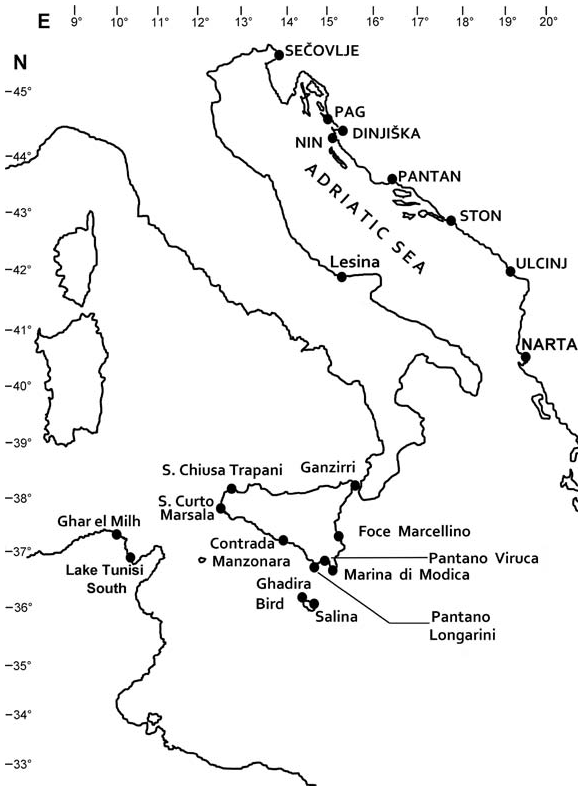
Fig. 1. – Map of the investigated area with marked sampling locali- ties. The locations on the eastern Adriatic coast that were the main subject of the present study are marked in capital letters. From the remaining localities included in the map, mtDNA CR sequences were incorporated in the second data set and analysed to reveal the intraspecific phylogeographic structure of A. fasciatus .